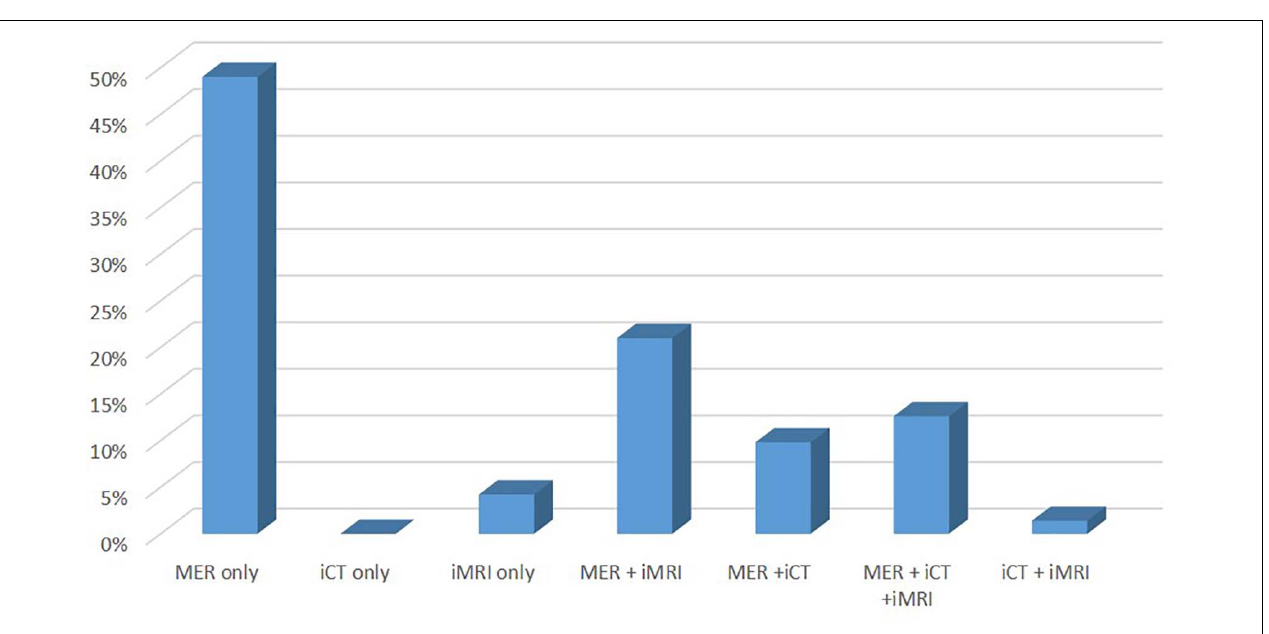
FIGURE 4 | The intra-operative technique reported to be utilized to evaluate and/or to confirm micro-macro-electrode position. Y-axis represents percentage of respondents reporting use of that technique. More than one technique may be used in a given institution. Abbreviations: MER, microelectrode recording; iCT, intraoperative computed tomography; iMRI, intraoperative magnetic resonance